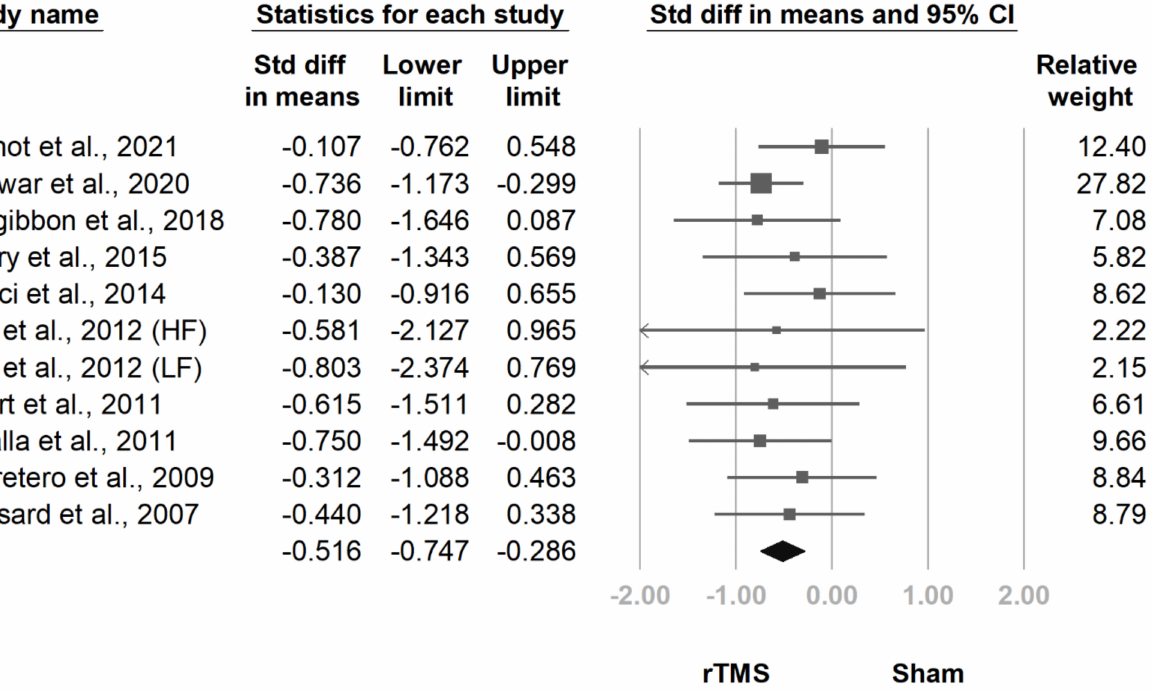
Figure 7. Forest plot of standardized mean differences in intensity of pain at follow-up at 2 weeks to 1 month after last treatment session. Squares indicate effect sizes of individual studies, lines indicate 95% CI, and diamond indicates the summarized effect size.